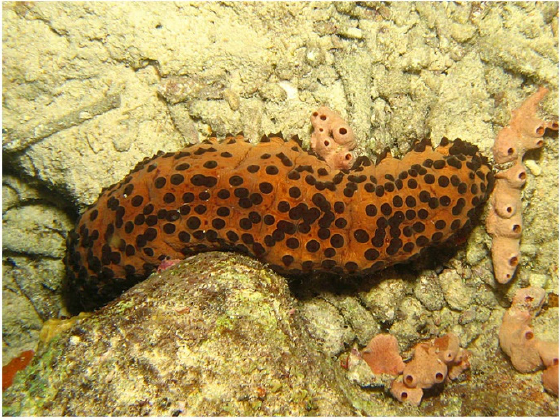
Figure 26. A specimen of Isostichopus badionotus . © Dan Hershman (CC BY 2.0); https: // commons. wikimedia.org /